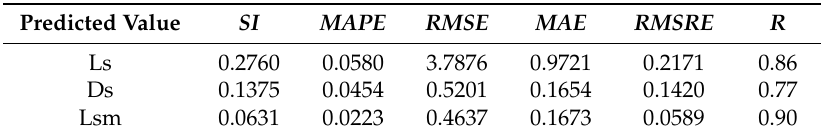
Table 3. The statistical performance of MARS models during validation period in prediction of Ls, Ds and Lsm using dimensional data.